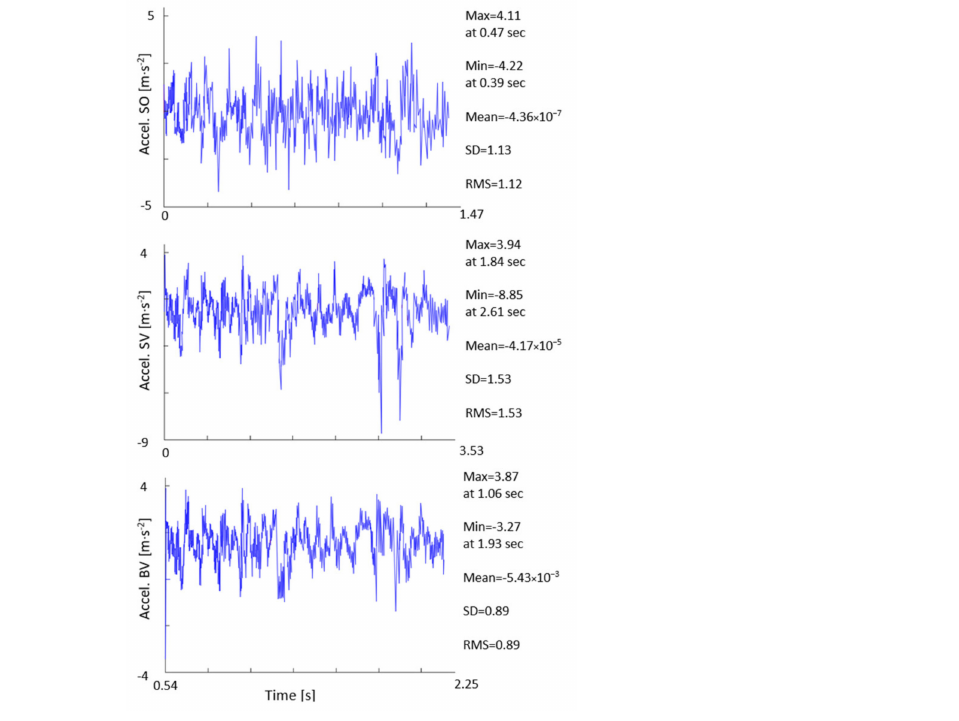
Figure 9. Vibration evolution during sowing on plot P2 at the working speed of 4 km · h − 1 .